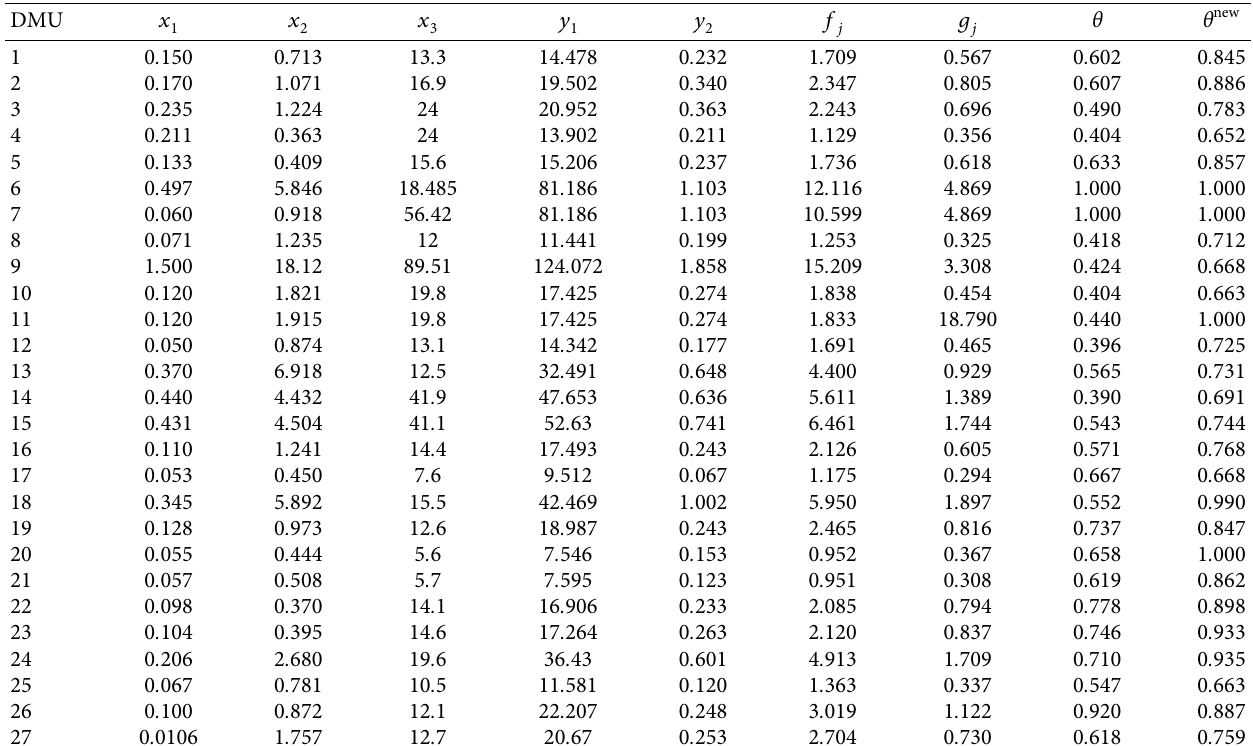
Table 4: An empirical